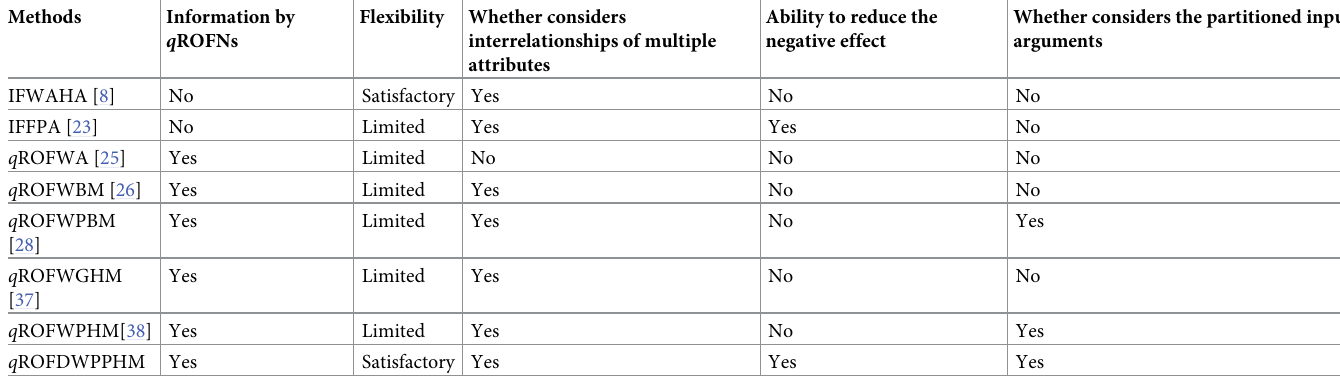
Table 10. The results of qualitative